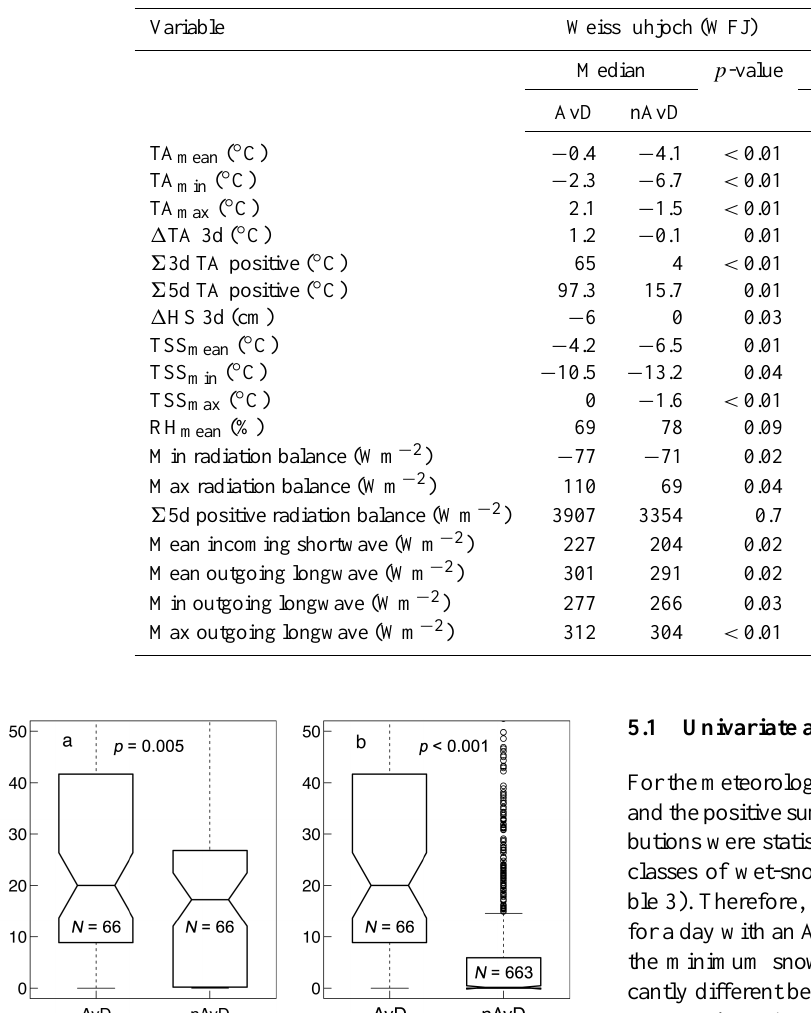
Table 3. Comparison of avalanche (AvD) to non-avalanche days (nAvD) for meteorological data measured at the weather stations Weiss- fluhjoch (2540ma.s.l) and Dorfberg (2140ma.s.l.). Median values are shown; Dorfberg values for the season 2007–2008 are substituted with values from Stillberg (2150ma.s.l.). For each variable, distributions from avalanche days and non-avalanche days were contrasted ( U -test), and the level of significance ( p -value) is given. Only variables with p < 0.05 are shown.